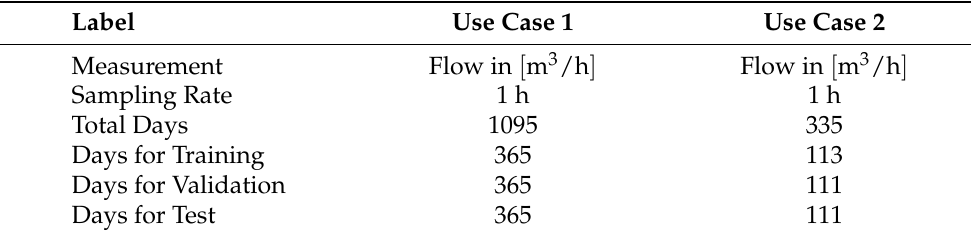
Table 1. Summary of datasets.